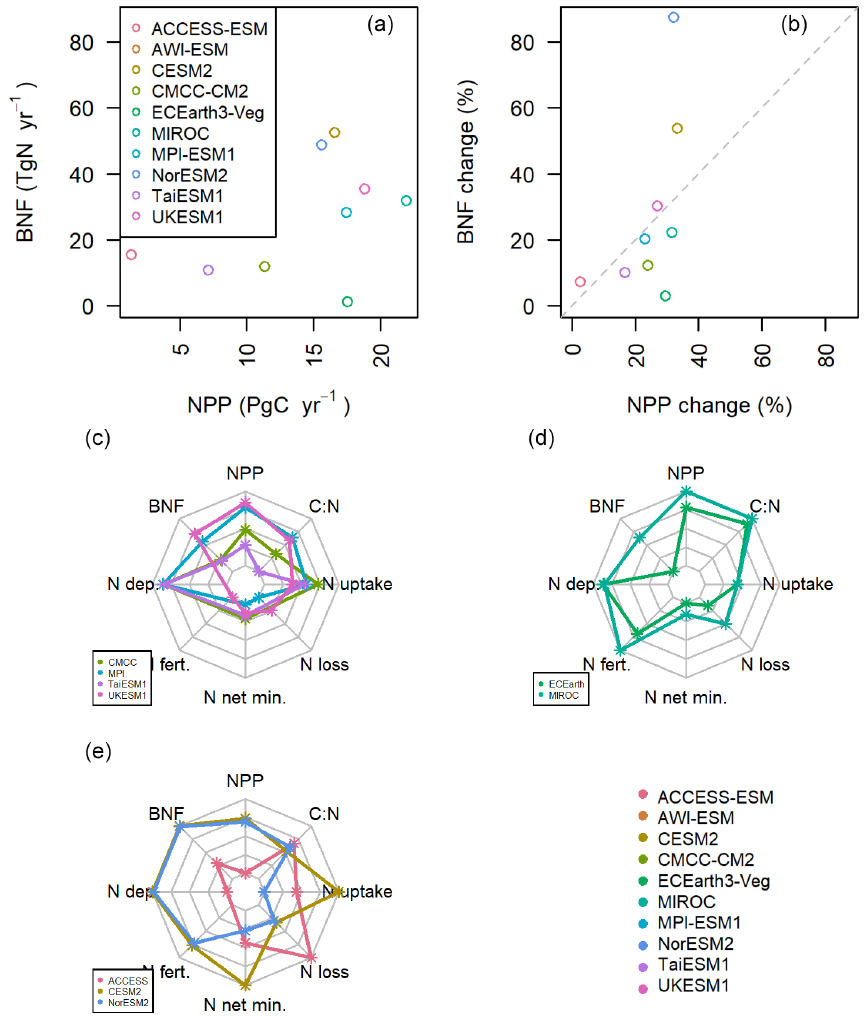
Figure 4. (a, b) The change in BNF and NPP between the first and last decade of SSP3-7.0. (c, d, e) The normalized changes in nitrogen components in the models. Each dot represents the normalized change in the variable during the 21st century in SSP3-7.0. Each line represents a model, and each plot is a group of models that deal with BNF similarly (from the top left: carbon cost or mechanistic, ET, and